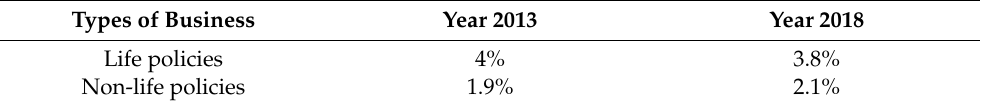
Table 1. Penetration rate life versus non-life policies (EY